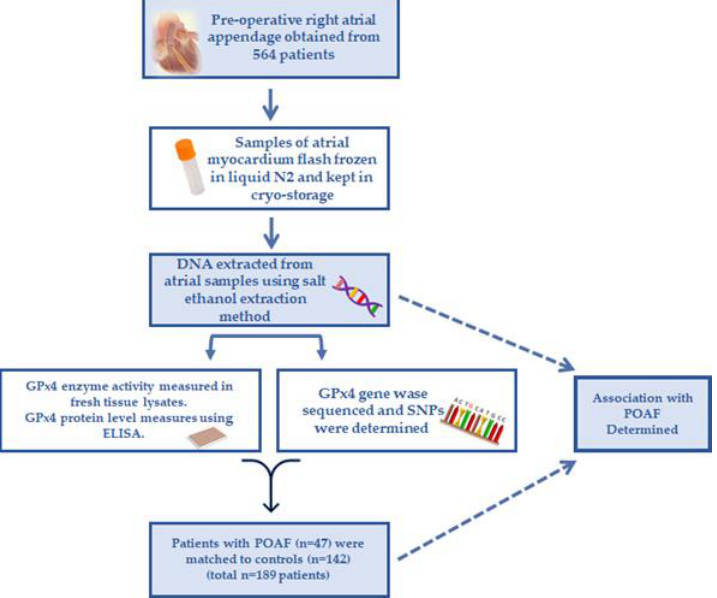
Figure 1. Overall study flow and design. Right atrial appendage samples were collected intra- operatively from patients undergoing non-emergent CABG. Salt ethanol method was used extract DNA from these samples. The genomic region encoding GPX4 was sequenced using Ion AmpliSeq (ThermoFisher) according to methods described in Methods section. GPx4 enzyme content and activity were measured as described in the Methods section. POAF: postoperative atrial fibrillation. CABG: coronary artery bypass graft.